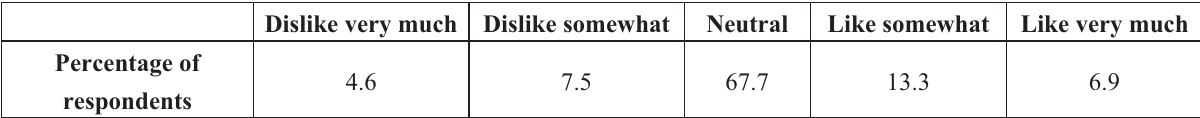
Table 2. Responses to the question: “How much do you like or dislike coyotes?” N = 758. Given in